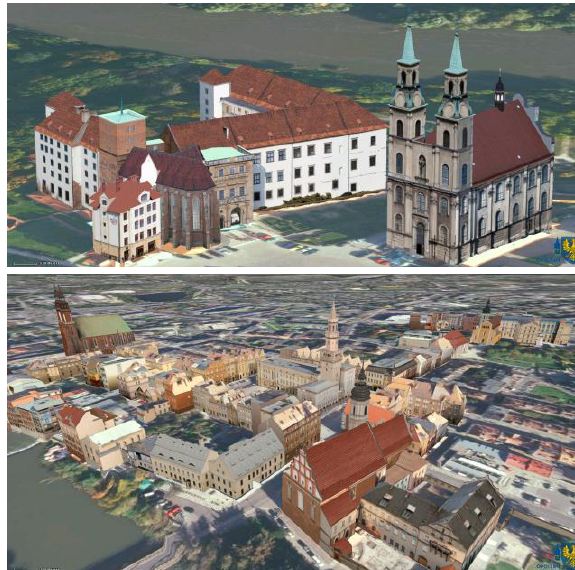
Figure 1. Investigated 3D models. Upper: “Object 1” (City Brzeg). Lower: “Object 2” (City Opole).